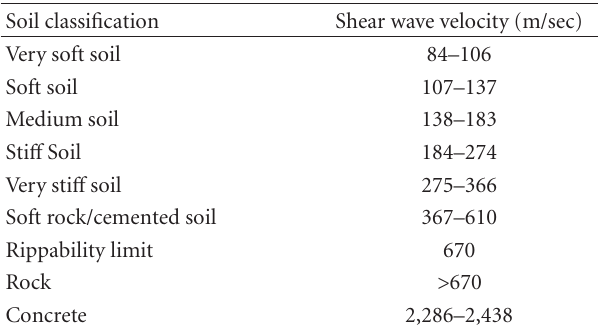
Table 1: Typical Shear Wave Velocities [22].